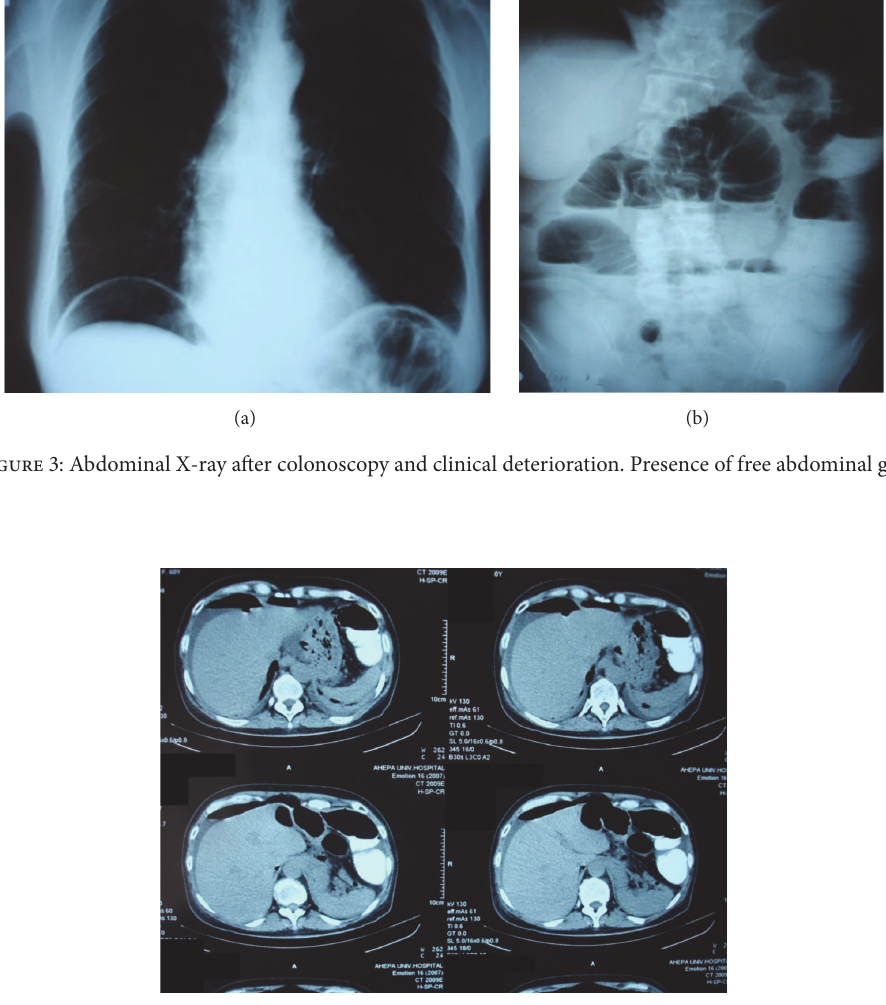
Figure 4: Abdominal CT scan. Perihepatic collection with free abdominal gas.